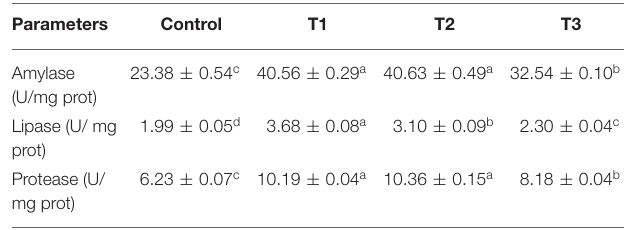
Data represent mean ± SE. Means with different letters (a–d) in the same row indicate significant differences (P < 0.05).